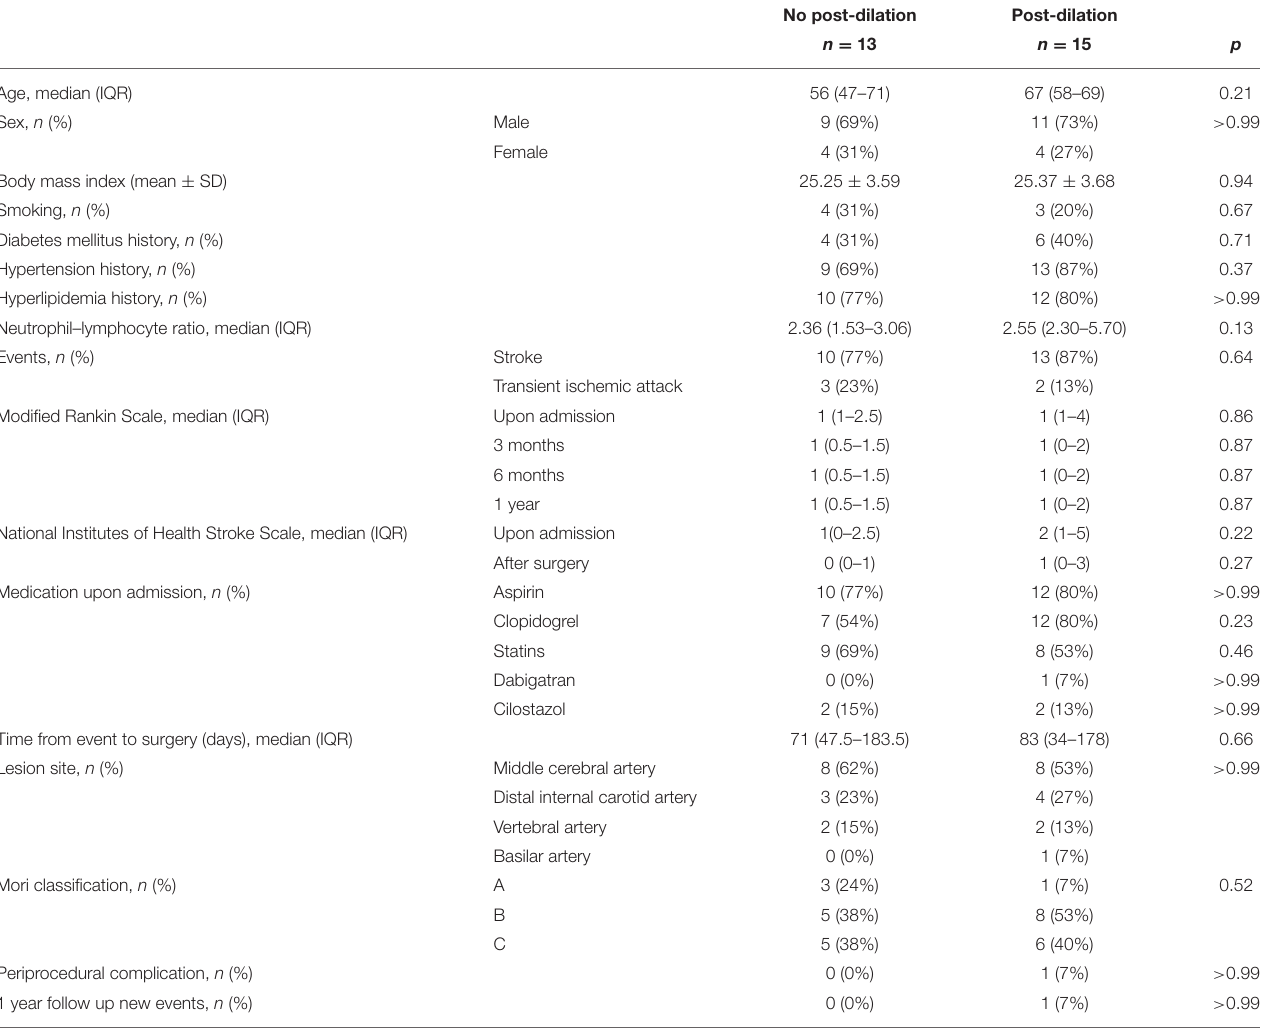
TABLE 1 | Basic demographics for the no post-dilation and post-dilation group.